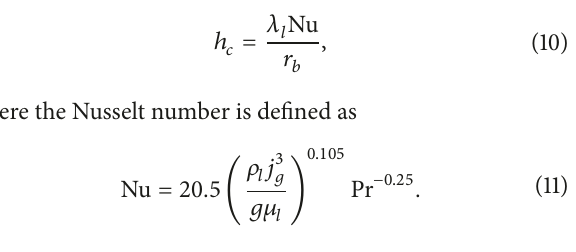
Figure 13: Partial pressure of carbon dioxide in the containment.